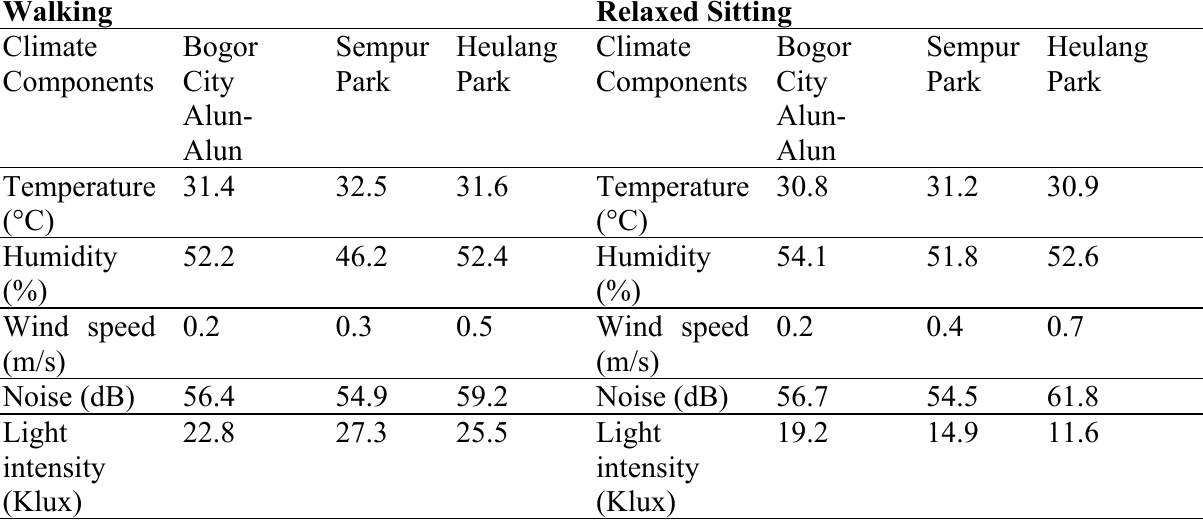
Figure 2. Experiment location. (A) Bogor City Alun-Alun. (B) Sempur Park. (C) Heulang Park. Table 1. Climate Components Average in Bogor City Alun-Alun, Sempur Park, and Heulang Park. Walking Relaxed